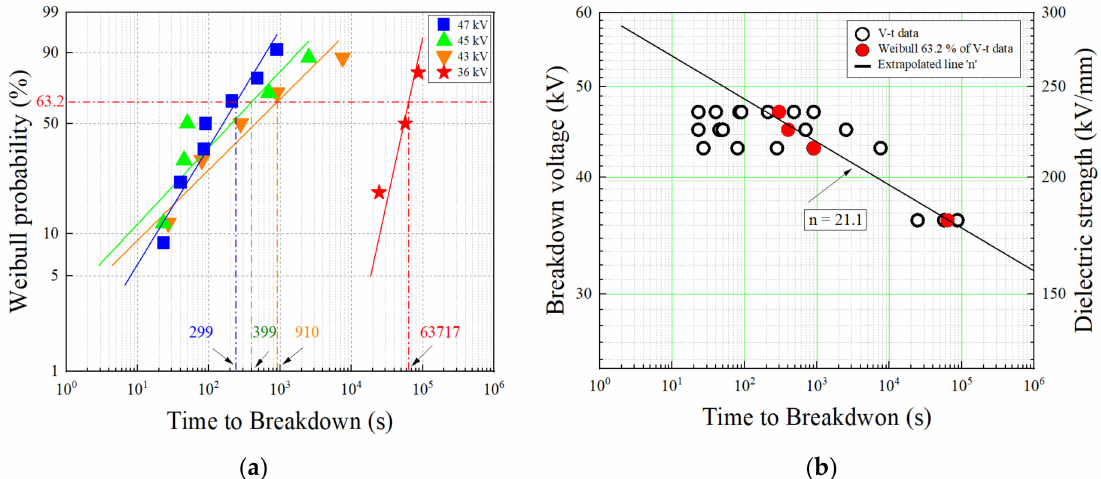
Figure 8. Breakdown data analysis on block copolymer and homo polymer: ( a ) Weibull distribution according to time to breakdown; ( b ) V-t graph to obtain life exponent and life estimation formula.